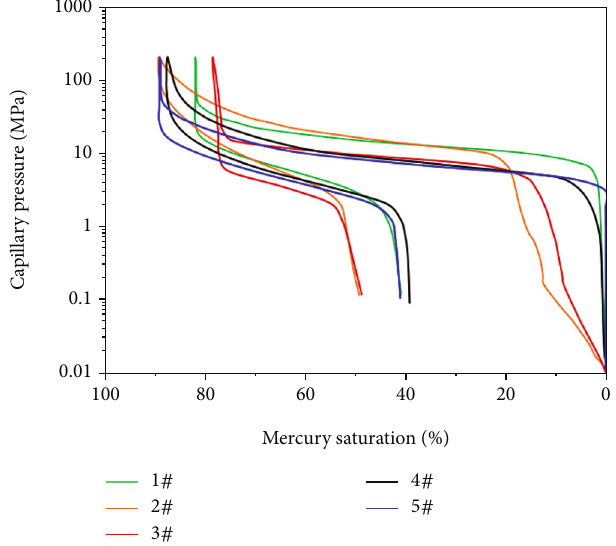
Figure 2: Capillary pressure curve of the III+IV oil group in Nanyishan Oil fi